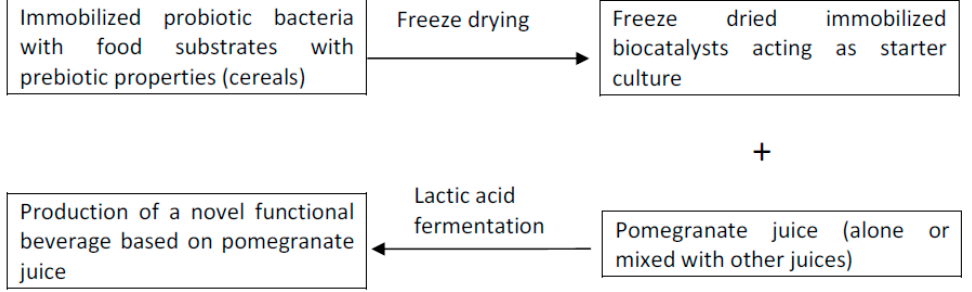
Figure 1. Proposed diagram for functional pomegranate juice production through fermentation with probiotic bacteria.